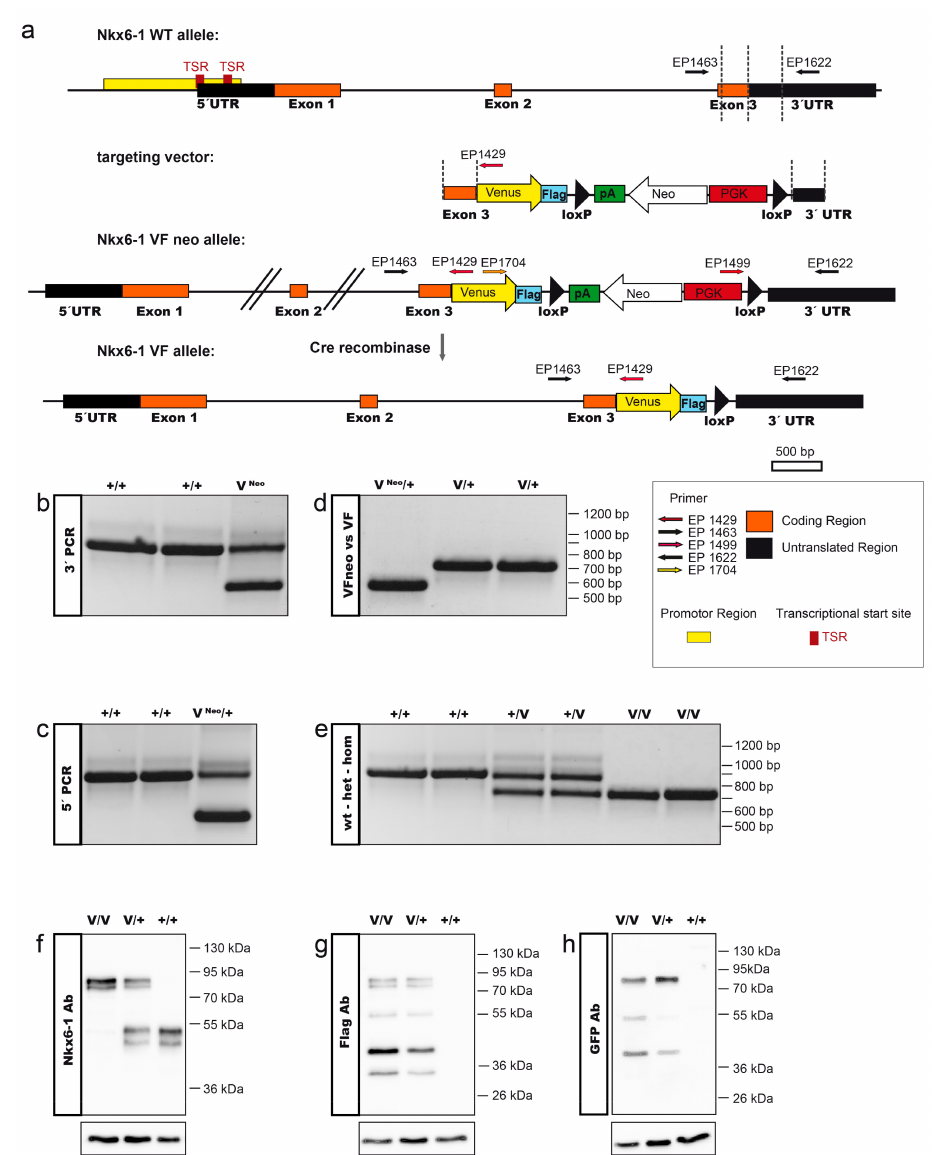
Figure 1. Generation of the Nkx6-1 Venus fusion (Nkx6-1-VF) allele. ( a ) Targeting strategy for the Nkx6-1-VF allele. A double strand break was introduced by two nicks of the D19A mutant Cas9 using two gRNAs (green arrows) binding before and after the stop codon of Nkx6-1. A targeting vector was used to repair the gap and fuse the coding region of the fluorescent report gene Venus to the open reading frame (orange boxes) of the Nkx6-1 gene. The loxP-flanked PGK-driven neomycin (Neo) selection cassette was removed by Cre recombinase-mediated excision. Nkx6-1 5 (cid:48) and 3 (cid:48) untranslated regions (UTRs) are indicated by black boxes, the predicted promoter region (yellow box) and transcriptional start sites (TSR, red boxes) are indicated. Primers used for PCR genotyping are designated EP1429, EP1463, EP1499, EP1622 and EP1704. The positions of the homology regions to generate the targeting construct are indicated by dashed lines. ( b , c ) PCR genotyping of Nkx6-1-VFNeo/+ mice using primers 1429, EP1463, EP1622 for the 5 (cid:48) PCR confirmation of the targeted allele Nkx6-1-VFNeo (545 bp) versus the WT allele (877bp) and the primers EP1463, EP1499 and EP1622 for the 3 (cid:48) PCR confirmation of the targeted allele Nkx6-1-VFNeo (591 bp) versus the WT allele (877bp). ( d ) PCR primers EP1499, 1622 and 1704 were used to distinguish the allele before (Nkx6-1-VFNeo; 591 bp) and after removal of the Neo selection cassette (Nkx6-1-VF; 741 bp). ( e ) Primers EP1463, EP1622 and EP1704 were used to distinguish WT from heterozygous or homozygous mice of Nkx6-1-VF resulting in 877bp for the WT allele and 741 bp for the targeted allele. ( f ) Western blot analysis on lysates from islets of Langerhans using Nkx6-1 antibody to detect the WT protein as double band at approximately 50 and 53 kDa and Nkx6-1-VF protein at 77 and 80 kDa. ( g , h ) Both Flag and GFP antibodies detected the Nkx6-1-Venus fusion protein at 77 and 80 kDa as well as several degradation products. β -tubulin was used for loading